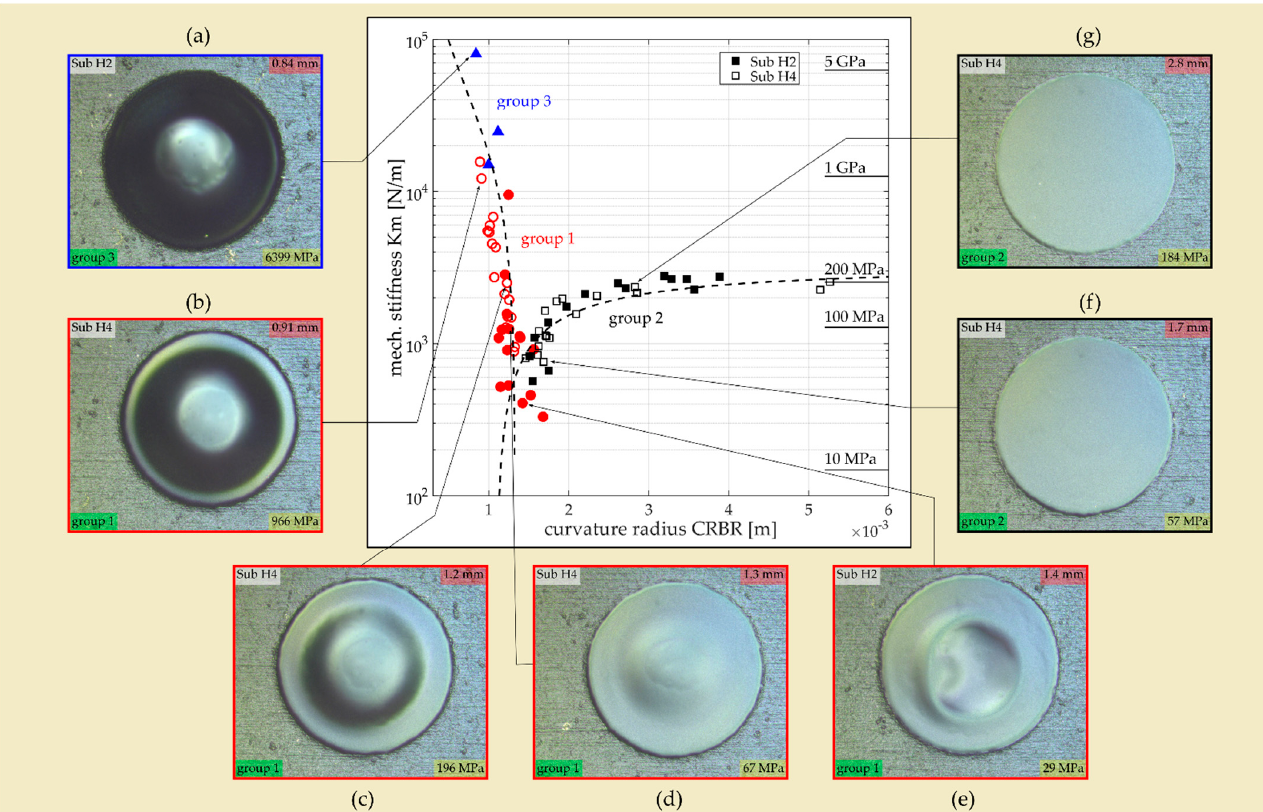
Figure 9. Diaphragm stiffness as a function of the diaphragm’s curvature radius before it is released from the SM (CRBR) for diaphragms of the substrate H2 (filled markers) and H4 (empty markers). Group 1 diaphragms are indicated with red circles, group 2 with black squares, and group 3 with blue triangles. The stiffness-related intrinsic stress is indicated on the right y -axis (only valid for group 2 diaphragms). The dashed lines represent trendlines assuming linear behavior if the stiffness is considered in linear space. ( a – g ) Optical microscope images showing the diaphragm’s surface geometry (after release) depending on the CRBR. The CRBR and the intrinsic stress values are indicated in the images with a red and yellow background color, respectively. The group name is highlighted green.